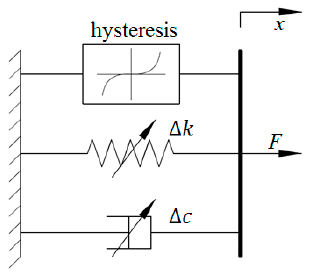
Figure 9. Hyperbolic hysteresis model.